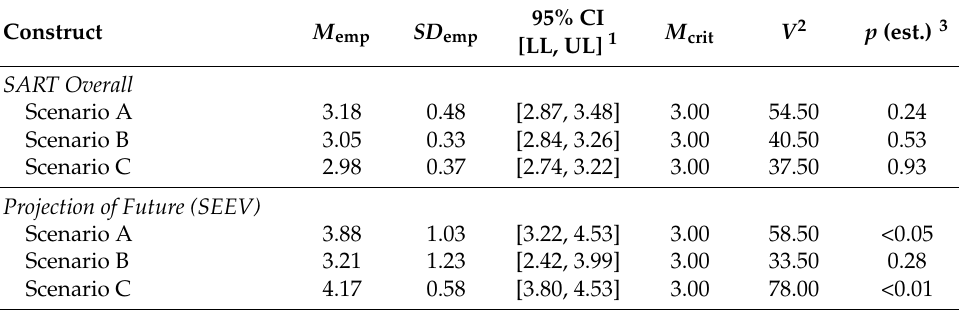
Table 6. Descriptive and inferential statistics regarding situation